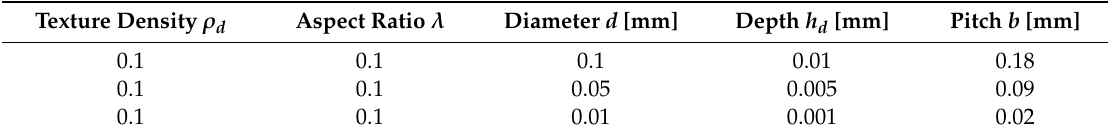
Table 1. Geometrical parameters of micro dimple